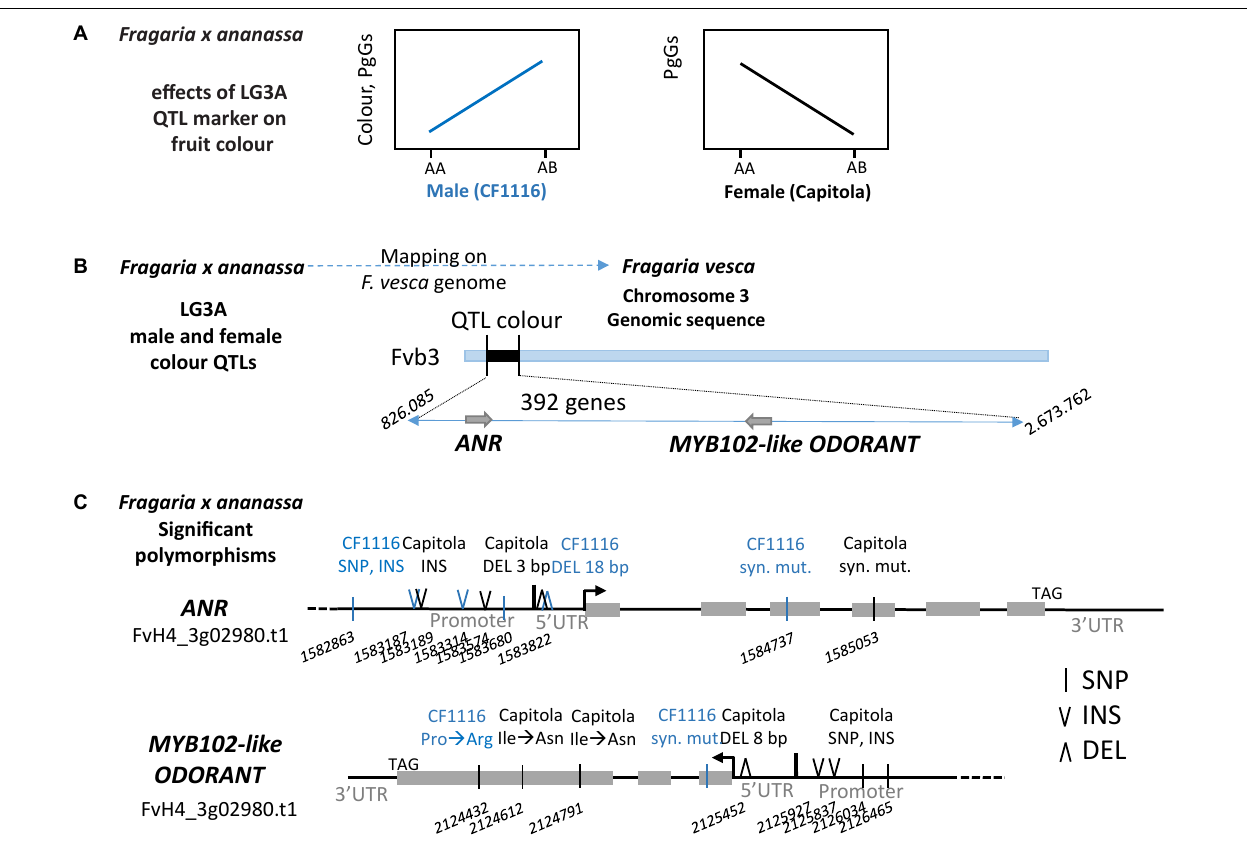
FIGURE 5 | Polymorphisms identified in the MYB102-like ODORANT and ANR genes. Schematic representations of (A) effects of LG3A QTL markers: positive effect of the male marker and negative effect of the female marker on fruit colour and (B) the position of the M3A/F3A QTL interval on chromosome Fvb3. (C) Polymorphisms found in the two candidate genes ANR ( FvH4_3g02980 ) and MYB102-like ODORANT ( FvH4_3g03780 ). Only polymorphisms between “Capitola” (in black) and “CF1116” (in blue) that respond to a Chi-squared test for the presence of 1 allele out of the 8 alleles (1:7 ratio) are reported. DEL, deletion; INS, insertion; SNP, single nucleotide polymorphism; syn. mut., synonymous mutation. Three letter code is used for amino acids. Grey box represents exon. Numbers refer to positions on Fvb3 ( Fragaria vesca Whole Genome v4.0.a1 Assembly).